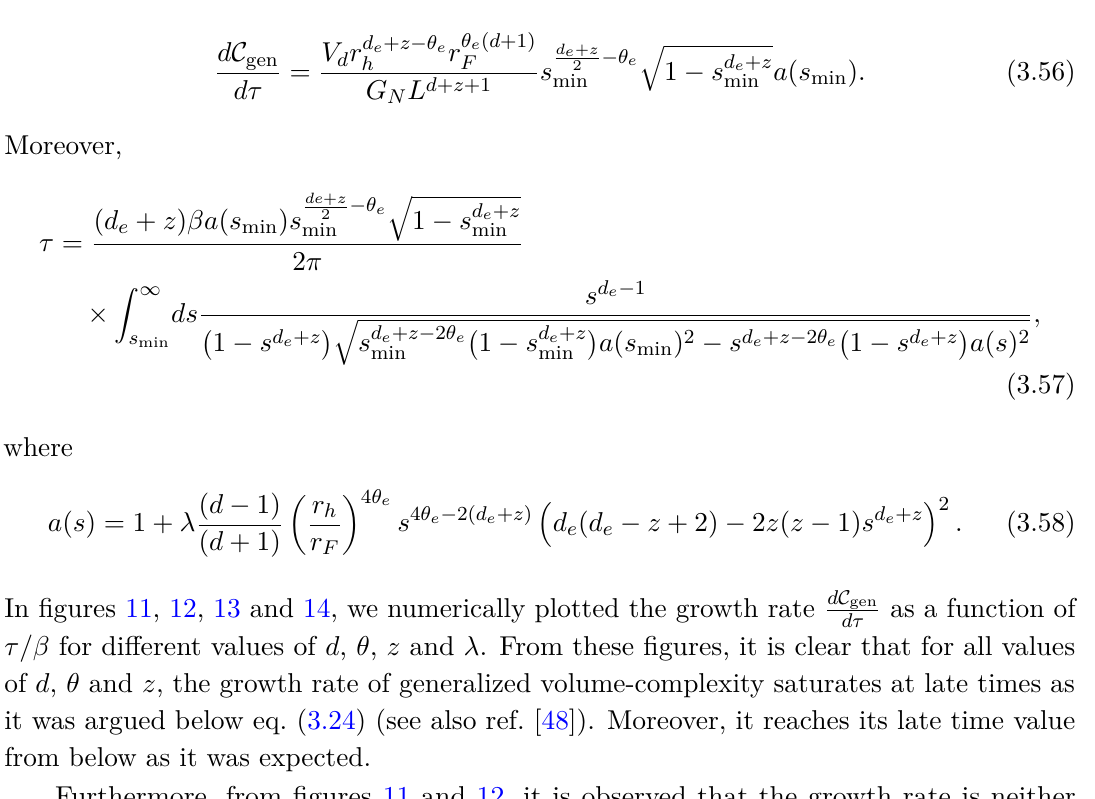
Figure 11 . The growth rate d C gen of d , θ and z : Left ) θ = 0 , z = 1 , Right ) θ = 1 λ = 10 − 5